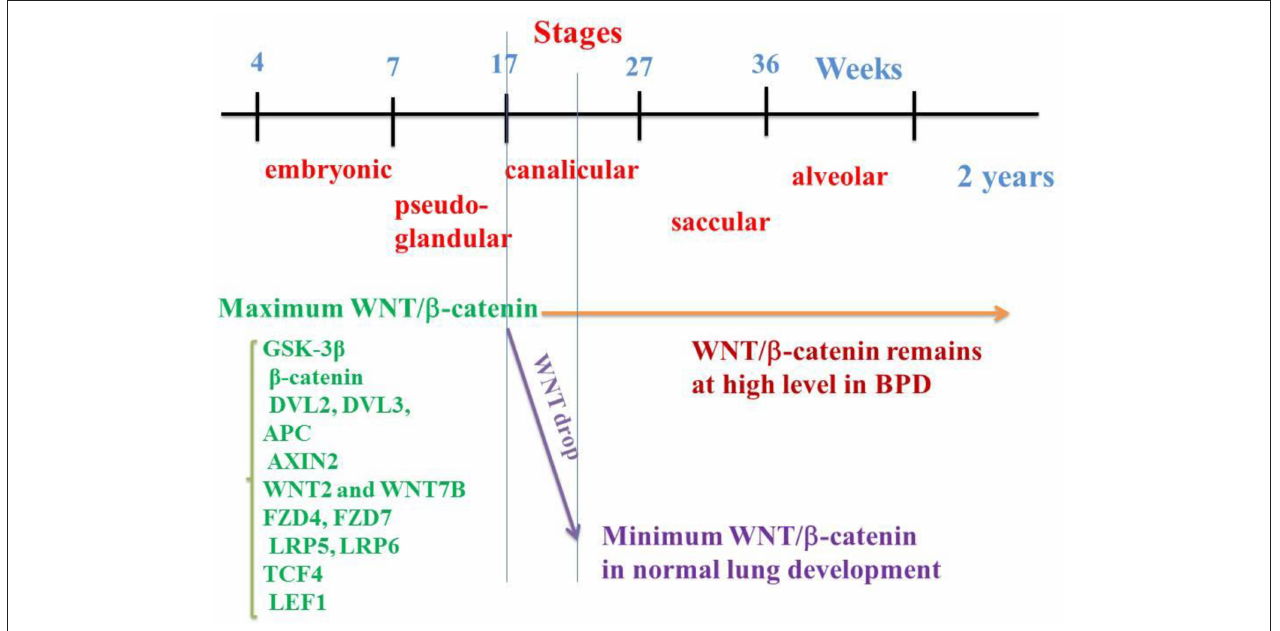
FIGURE 1 | WNT/ β -catenin pathway on the embryological pulmonary development in humans. Five stages classically follow one another: embryonic, pseudo-glandular, canalicular, saccular, and alveolar. WNT/ β -catenin signaling reaches a maximum activation at the 17th week (end of the pseudo glandular stage or beginning of the canalicular stage). In the middle of the canalicular stage (around the 21st week), canonical WNT pathway activity decreases dramatically, a necessary prerequisite for the correct realization of the alveolar stage. In the event of premature birth, the thick alveolar walls do not allow sufficient gas exchanges, which